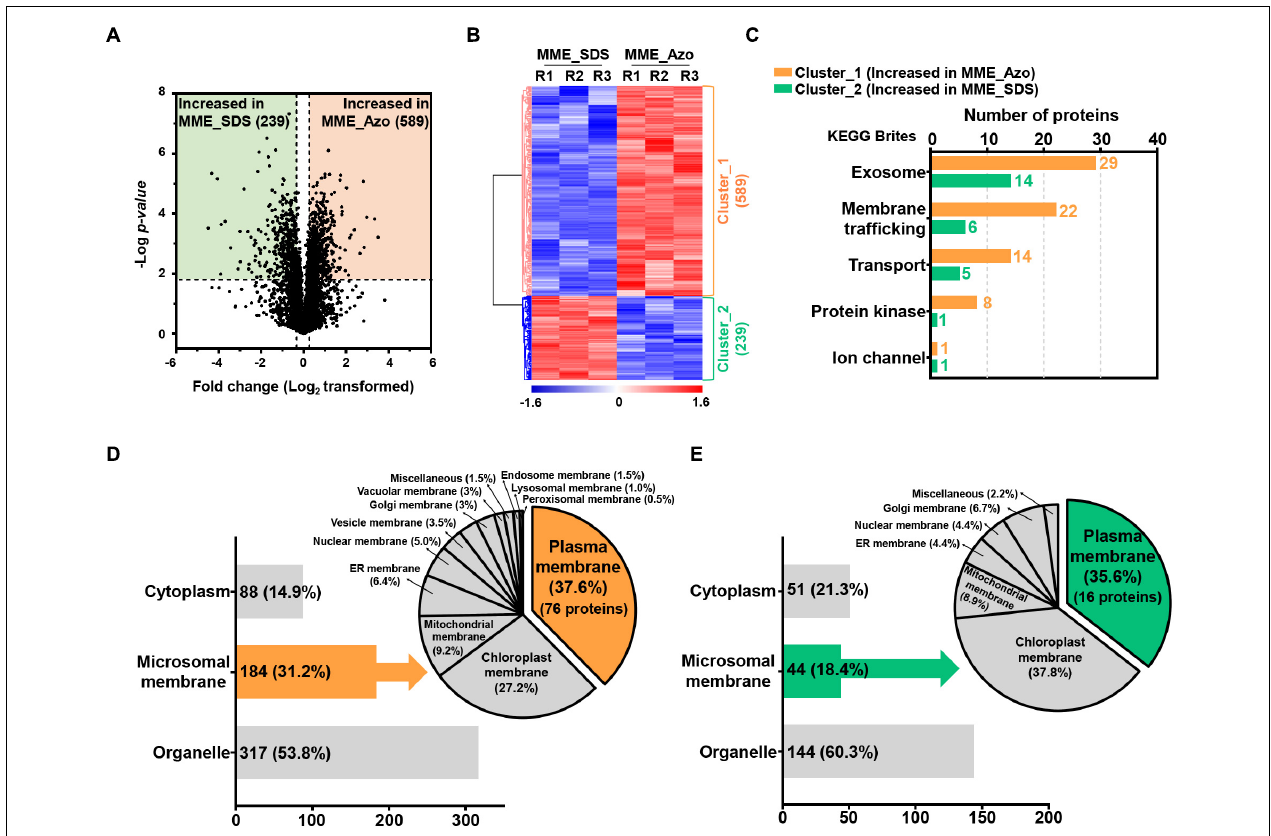
FIGURE 5 | Determination of the abundance profiles and functional classifications of the significantly modulated proteins solubilized in SDS and Azo. Volcano plot (A) and HCA (B) highlighting the relative fold change differences of the identified proteins from the microsomal membrane fractions solubilized by SDS and Azo. (C) The functional classifications of significantly modulated proteins by KEGG pathway analysis using the KEGG brite database. (D) Subcellular localization analysis of the proteins with increased abundance in MME_Azo (cluster_1) (D) and MME_SDS (cluster_2) (E) , respectively. Representatively, three major localizations including the cytoplasm, microsomal membrane, and organelles were predicted by UniProt and the CELLO2GO web-based